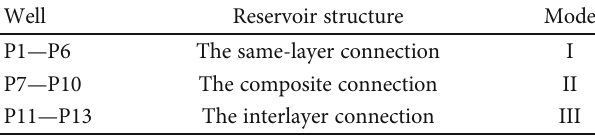
Figure 4: Geographic location map of Akpo oil fi elds. Table 1: The 13 typical producing wells in Akpo oil fi